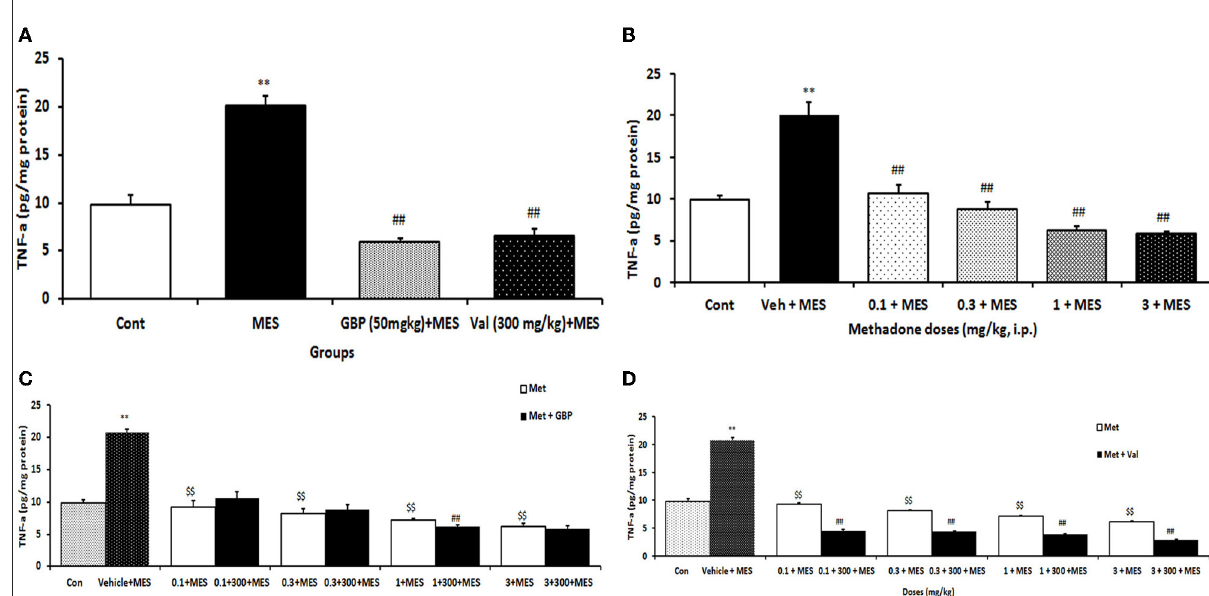
FIGURE2 Changes of TNF- α (pg/mg protein) in the brain of mice in different treatment groups: (A) changes of brain TNF- α level in the saline-treated control, 50 mg/kg i.p. gabapentin (GBP) and 300 mg/kg i.p. valproate (Val)-treated groups after MES-induced seizure; (B) changes of brain TNF- α level of mice after treatment with (0.1, 0.3, 1, and 3 mg/k i.p.) Met and MES-induced seizure; (C) changes of brain TNF- α level treated with GBP (50 mg/kg i.p.) per se and different doses of Met plus GBP before MES; (D) changes of brain TNF- α level treated with valproate (Val) (300 mg/kg i.p.) per se and different doses of Met plus Val before MES. Data are expressed as mean ± SEM. N = 10. ** p < 0.01compared with the normal group, $$ p < 0.01 treatments vs. vehicle + MES, and ## p < 0.001 compared with the saline + MES group using two-way ANOVA followed